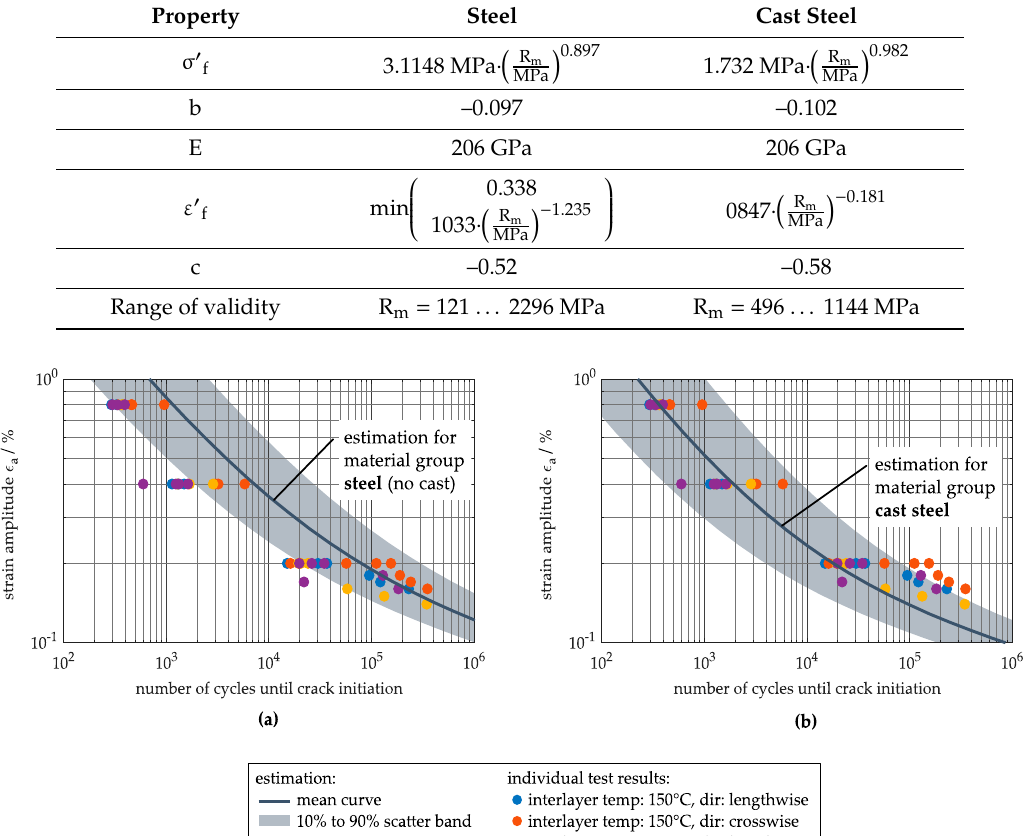
Table 6. Method for estimating cyclic properties (for the material groups steel and cast steel) [27]. Property